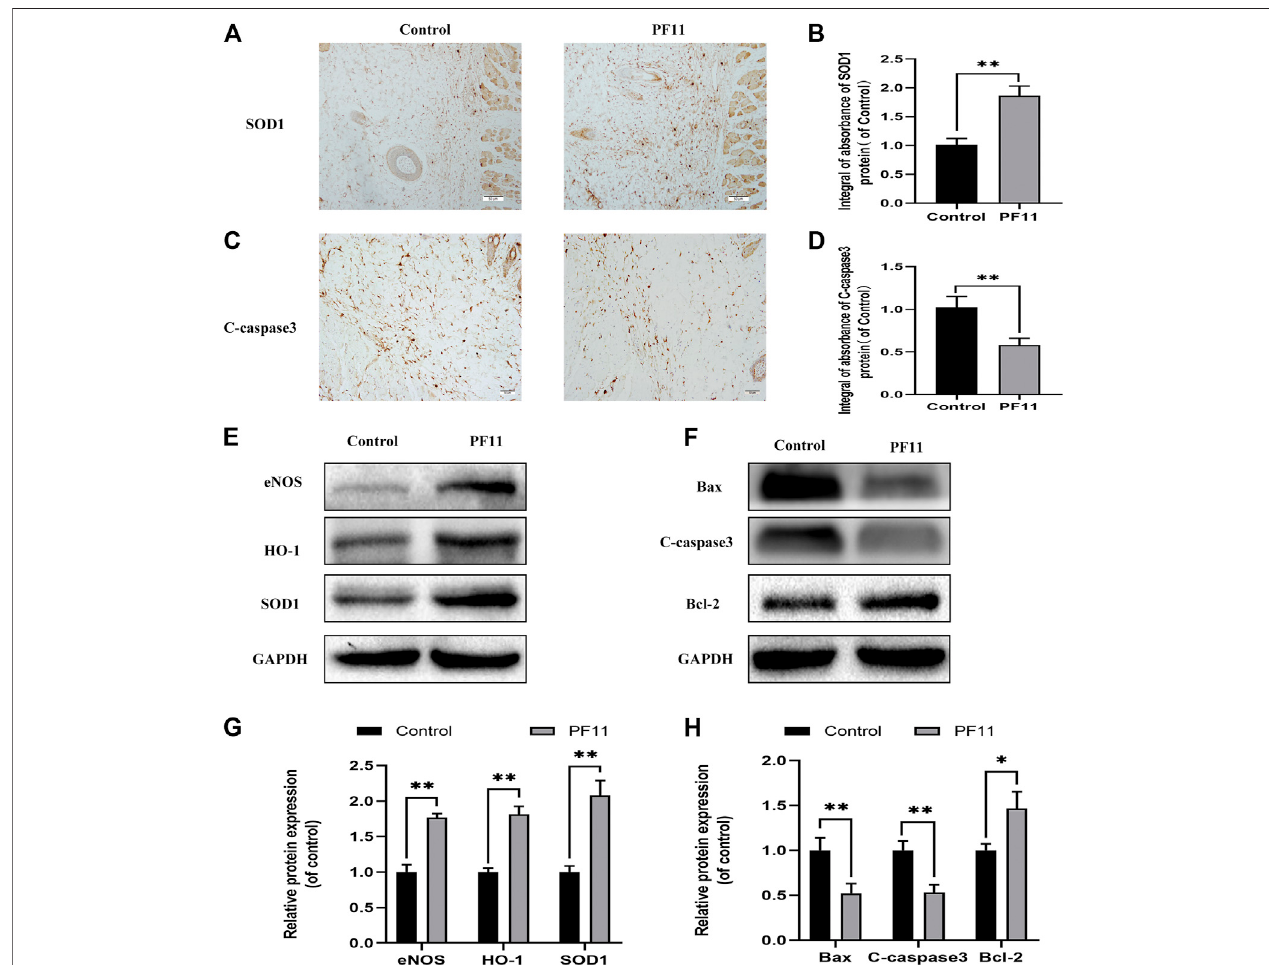
FIGURE3| PF11reducesoxidativestressandalleviatesapoptosisinskin fl aps. (A) IHCwasperformedtoassessthelevelofSOD1positivecellsinskin fl aps(scan bar, 50 μ m). (B) The integral absorbance of SOD1 in the dermal layer. (C) The expression of C-caspase3 was evaluated by IHC in Area II of skin fl aps (scan bar, 50 μ m). (D) TheintegralabsorbanceofC-caspase3wasquanti fi edbyImage-ProPlus. (E,F) ResultsofwesternblottingshowingtheexpressionofSOD1,eNOS,HO1,Bax,Bcl- 2, andC-caspase3. Cropped blotsareshown. (G,H) Theopticaldensity valuesofSOD1,eNOS, HO1, Bax,Bcl-2, andC-caspase3expression inthe fl aps. Values are expressed as means ± SD, n (cid:2) 6 per Group. * p < 0.05 and ** p < 0.01, vs. control